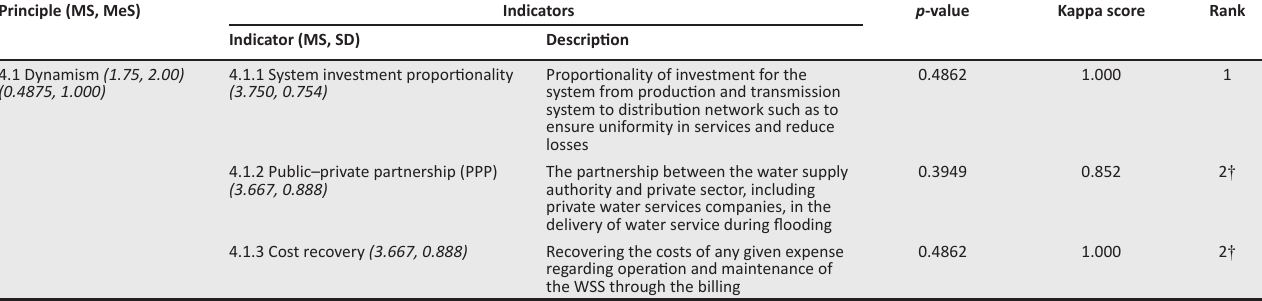
TABLE 8: Tools for measuring the economic resilience for water supply systems in Tanzania. Principle (MS,